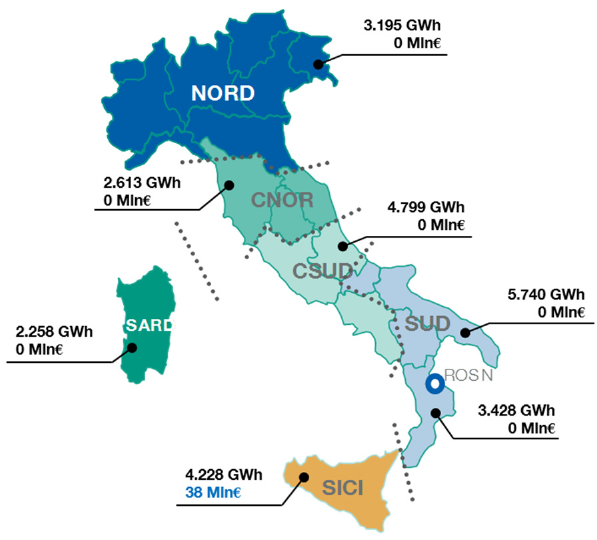
Figure 11. Auction Figure 11. Auction results.